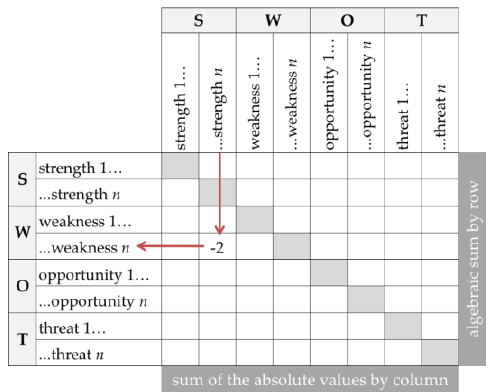
Figure 2. The spreadsheet used for the pairwise comparison of the items. Panel participants were asked to compare each item in the column headers with all the other items in the row headers, irrespective of type (i.e., strength, weakness, oppor- tunity, or threat), and to assign a score of between −2 and +2 to each couple. A positive value indicates that the effect of the item in the row is increased by the effect of the column item, while a negative value implies that the column item impedes or decreases the effect of the item in the row. Scoring criteria were as follows: ● −2 = the effects of the row item are strongly hampered by the column item, ● −1 = the effects of the row item are hampered by the column item, ● 0 = the two items are independent, ● +1 = the effects of the row item are increased by the column item, ● +2 = the effects of the row item are strongly increased by the column item. Figure 2 presents an example in which the n -th strength strongly reduced the effect of the n -th weakness. Rating the impact that each item of the SWOT matrix has on any other item, and then summing the scores along the rows and columns allowed identification of items that are more influenced by the overall effect of other items and which items more effectively in- fluence others. In brief, the algebraic sum along the rows indicates the net capacity of the row items to exert their effects as a result of the influence of all the other items. This is true because some of them reinforce the effect of the row item and others weaken it, making the SWOT items in the rows dependent variables. Summing the absolute values of the scores in the columns weights the strength with which the column items are able to influ- ence the other elements, strengthening or weakening them. In this case, the column items are analysed as independent (or explanatory) variables. With this approach, two rankings are compiled with the SWOT elements. When rank- ing was based on row sums, beekeeping farm resilience depended on the positioning at the top of the rank of favourable conditions (strengths/opportunities) or unfavourable conditions (weaknesses/threats). On the other hand, ranking based on column sums high- lighted elements that could be leveraged to boost strengths/opportunities and limit weak- nesses/threats. To complete the exercise, two representatives from each of three groups were invited to participate in the process: two from beekeeper associations (one operating in northern Italy and one in central Italy), two honey market experts (one from a producers’ coopera- tive and one from the Italian National Honey Observatory), and two entomologists. As-